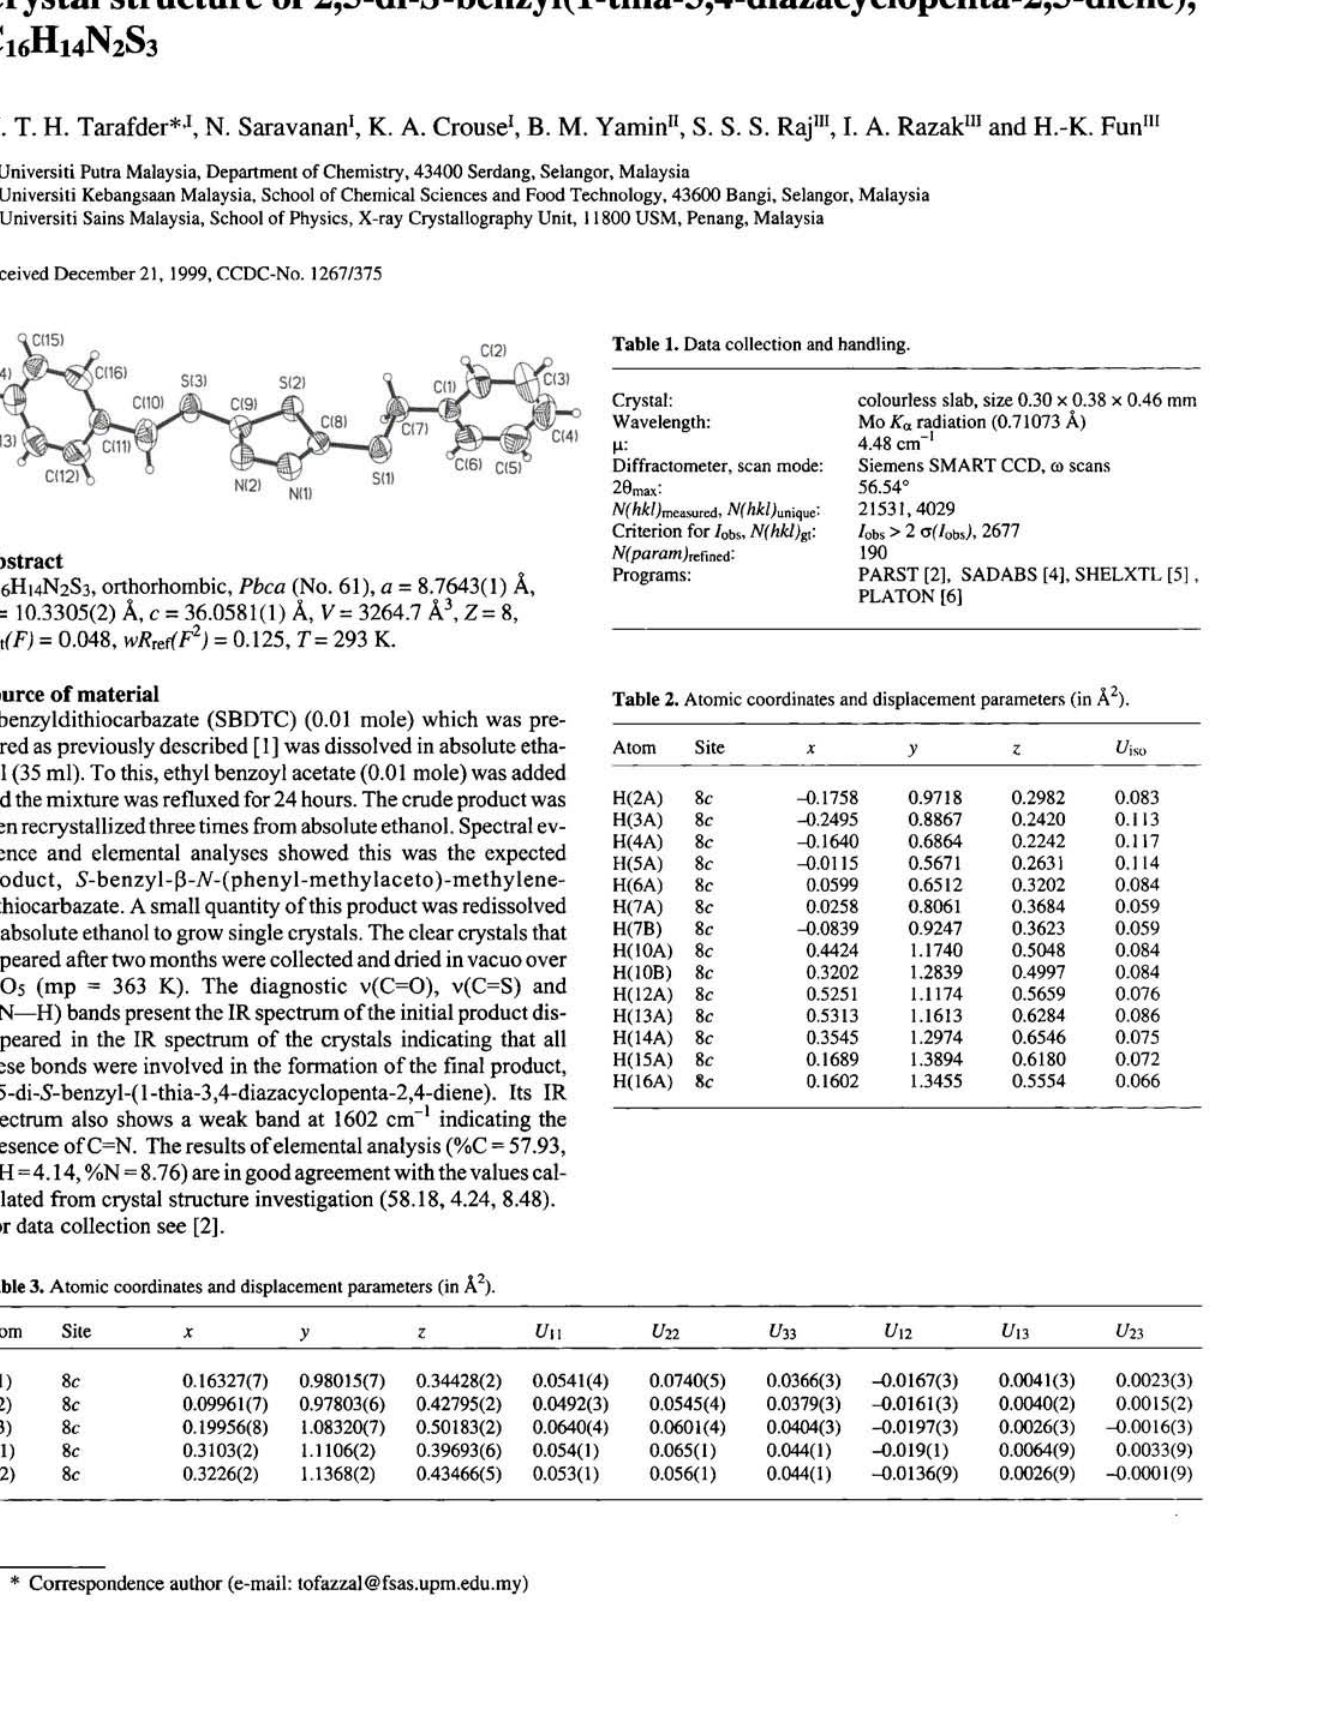
Table 1. Data collection and handling.